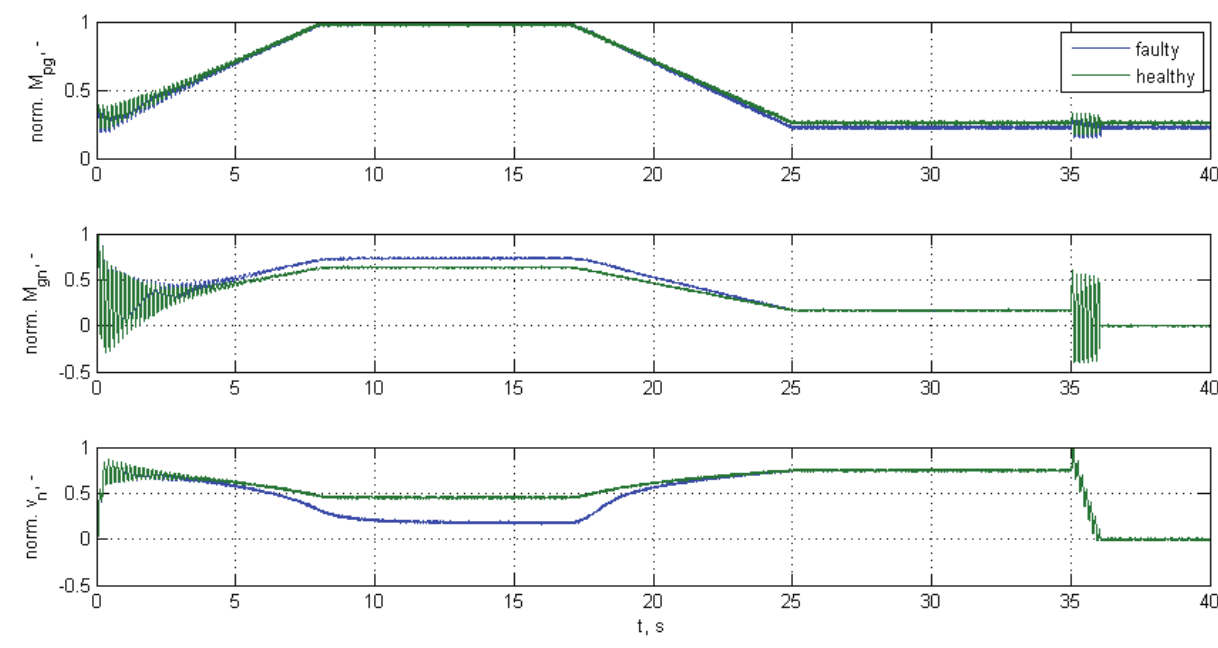
Fig. 12. Comparison of results of simulation following scenario S8 for healthy and faulty (U3)